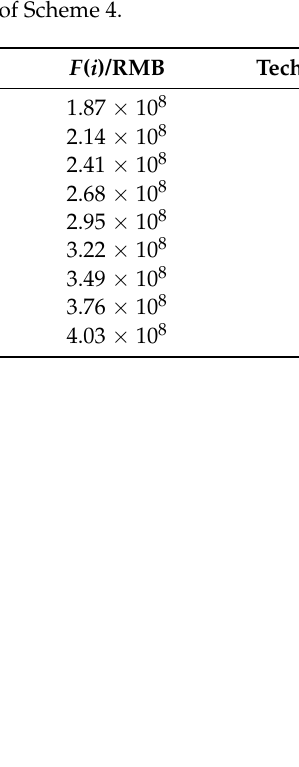
curve in Figure 9 correspond to the actual calculation results, while the whole dotted lines can only roughly fit the trends. Apparently, Scheme 2 is the best of the three schemes.